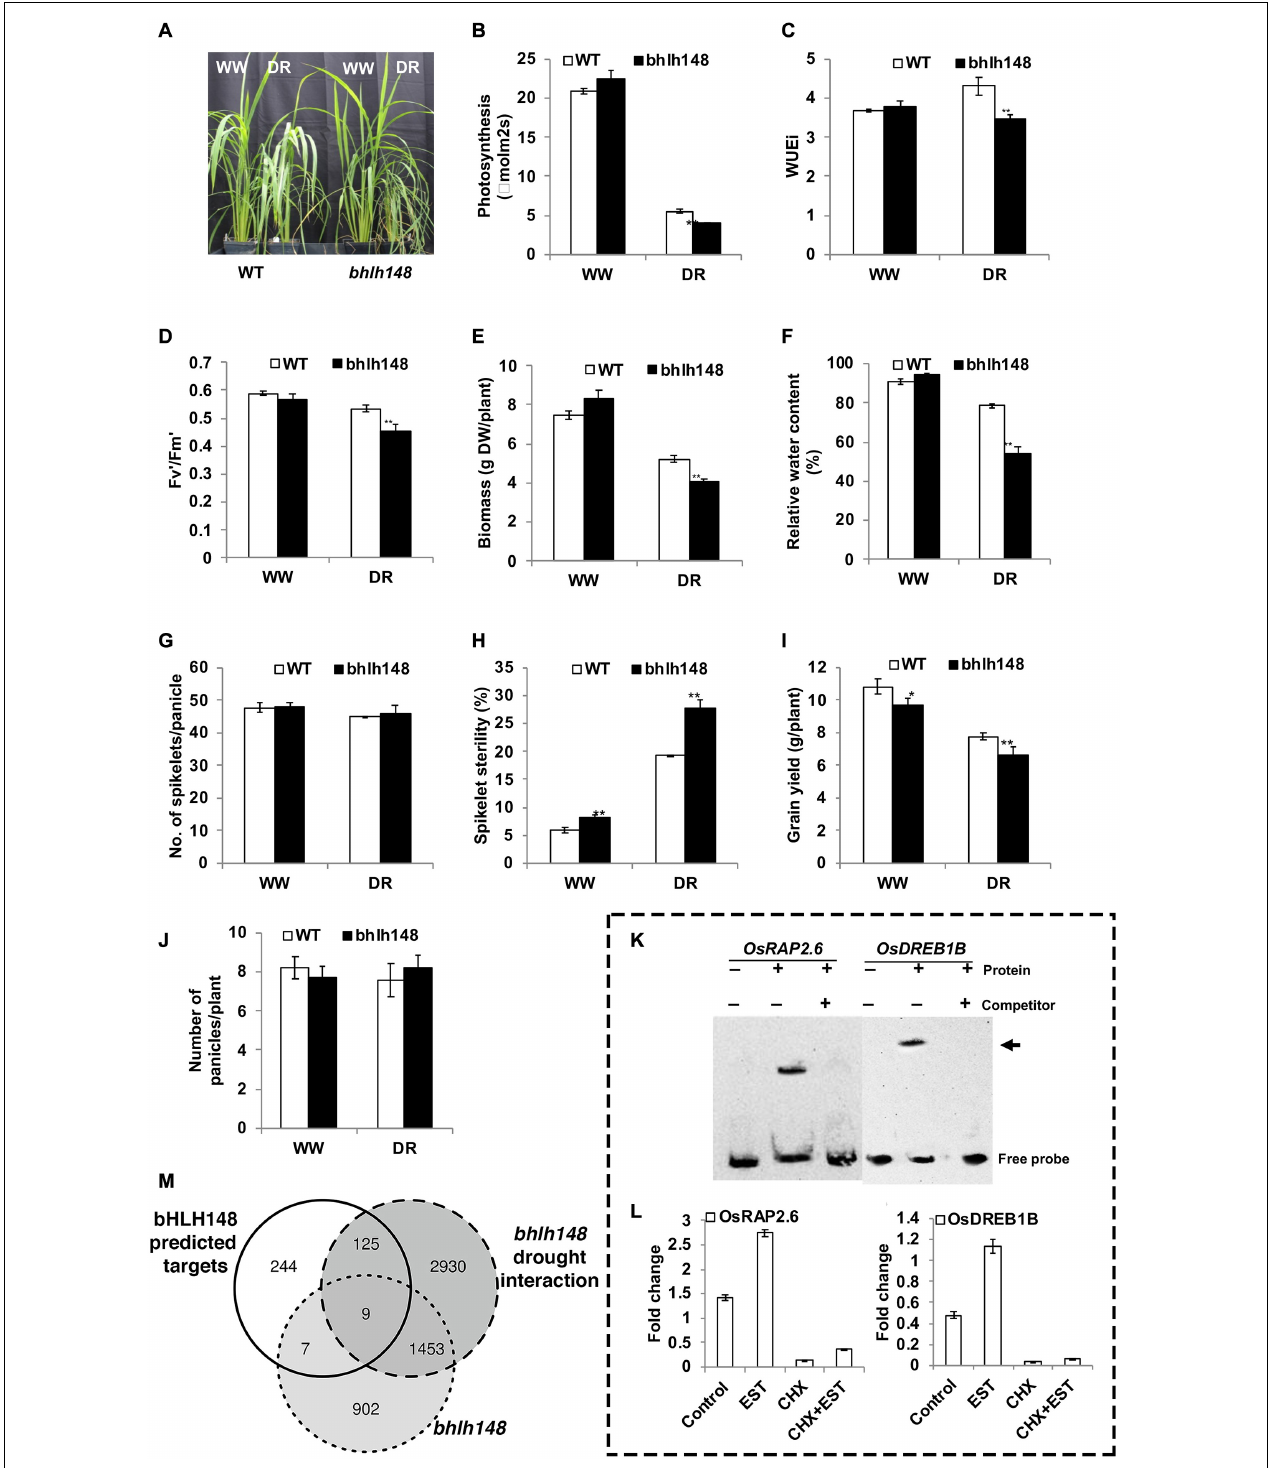
FIGURE 9 | Phenotyping bHLH148 as experimental validation of the GRAiN web application. OsbHLH148 was strongly predicted for association with drought by our network-based SVM classifier. We queried OsbHLH148 in the GRAiN web application and sought to test the predictions experimentally. (A) Increased sensitivity of bhlh148 mutant plants under controlled drought stress conditions. Forty-five-day old plants were maintained at 100% (well-watered – WW) and 40% (drought – DR) FC (field capacity) for 10 days by a gravimetric approach, and performance was measured at the end of the stress period. (B–F) The phenotype of the